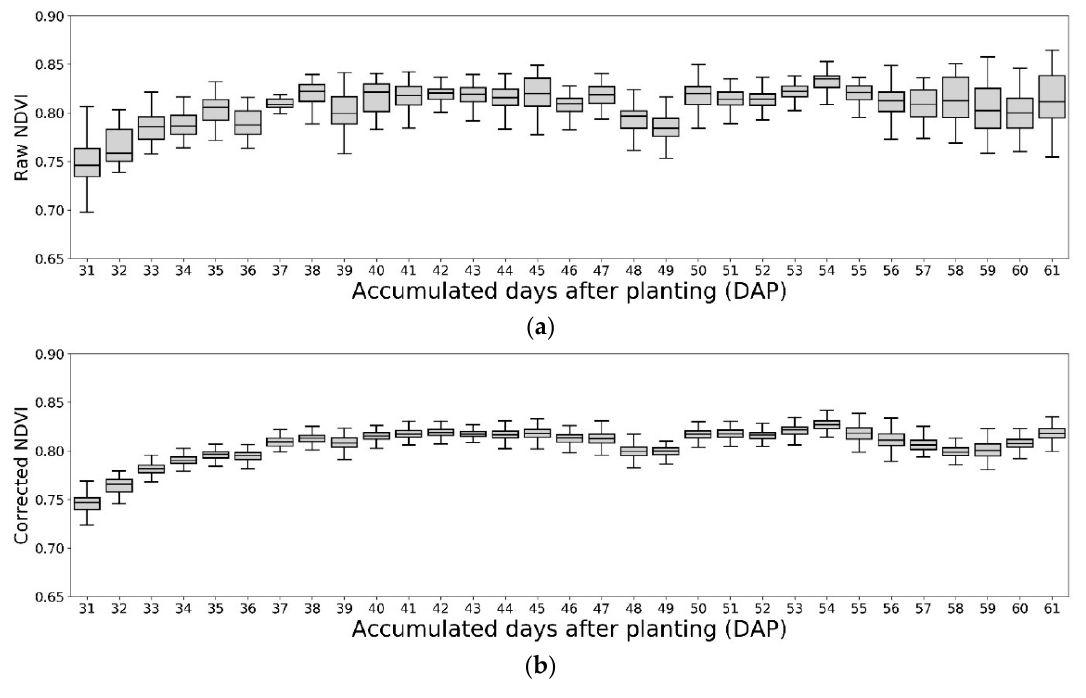
Figure 5. The five-fold cross-validated prediction results of environment-induced variation in NDVI for the sample dataset (G1H). The ANN prediction values show a significant correlation with R 2 = 0.823 and RMSE = 0.006.